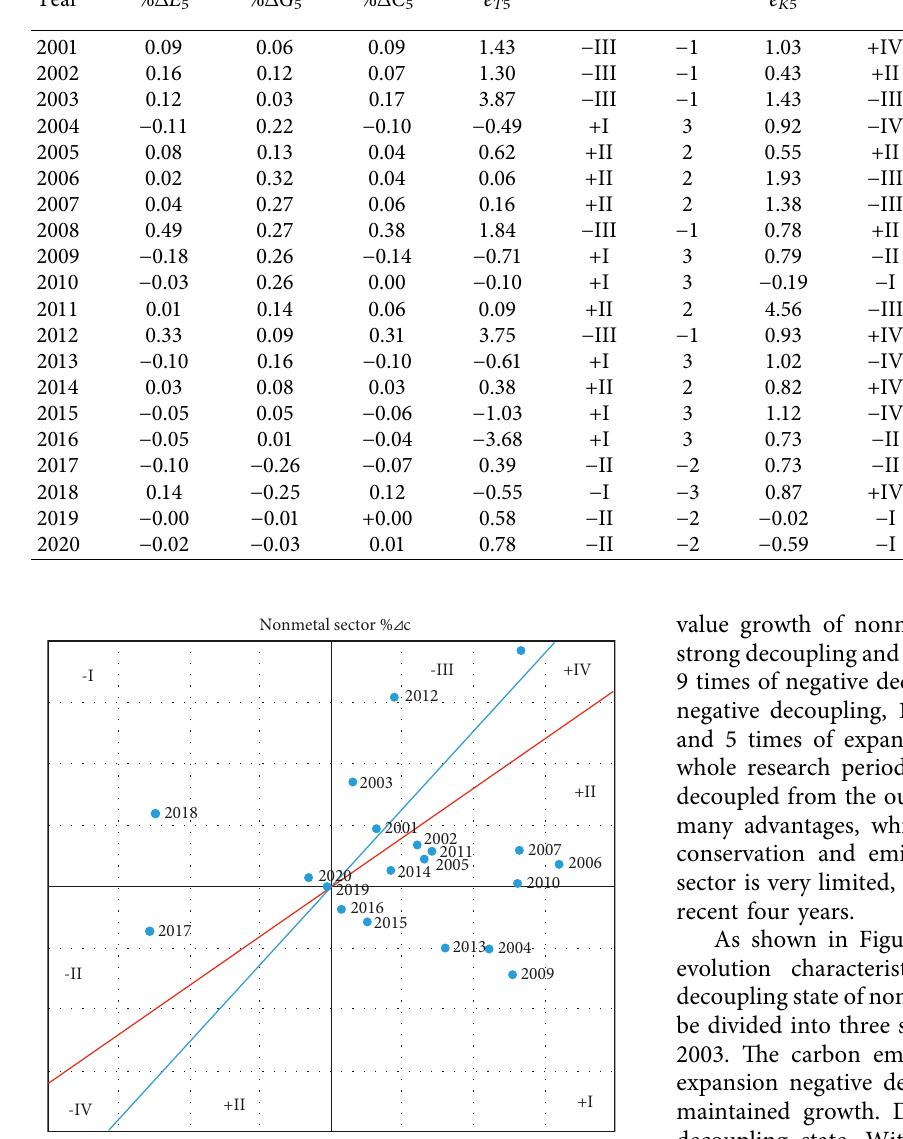
Figure 20: Carbon emission decoupling states of energy con- sumption in the nonmetallic sector from 2001 to